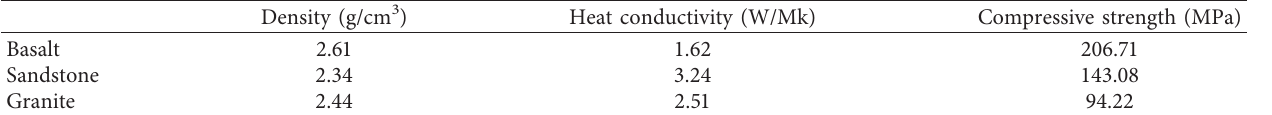
Table 1: Mechanical and thermal properties of rock samples.